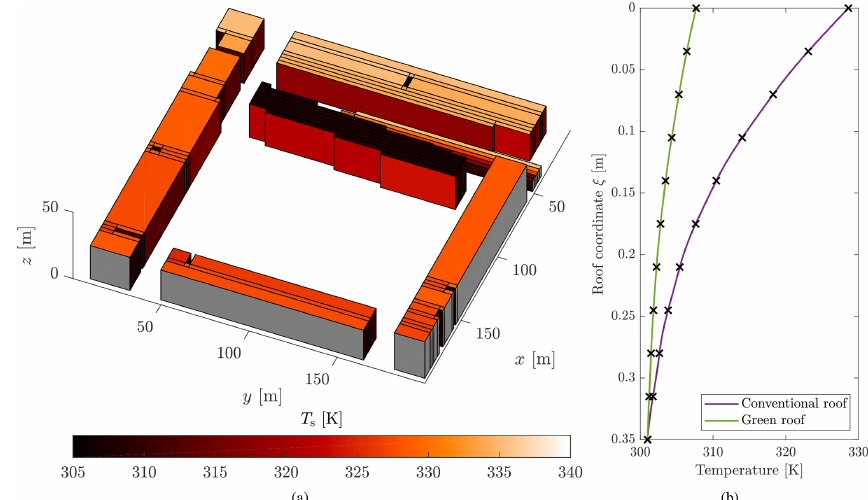
Figure 14. (a) The Eastside building and its surrounding. Building facets are coloured based on their final surface temperature. Floors are not coloured for clarity, and grey surfaces are building-internal. View from the direction of the sun. (b) Final internal roof temperature profiles for simulations with and without a green roof on the Eastside building. The initial temperatures were 301K throughout the